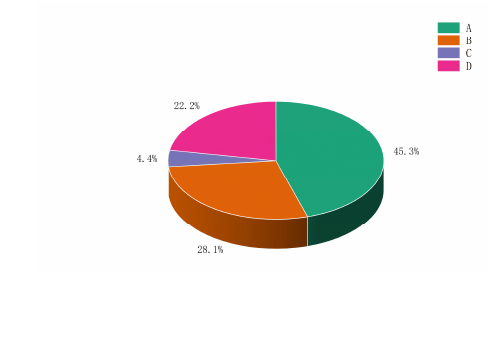
Table 4. Hourly variation coefficient of dry bulb temperature in Beijing.